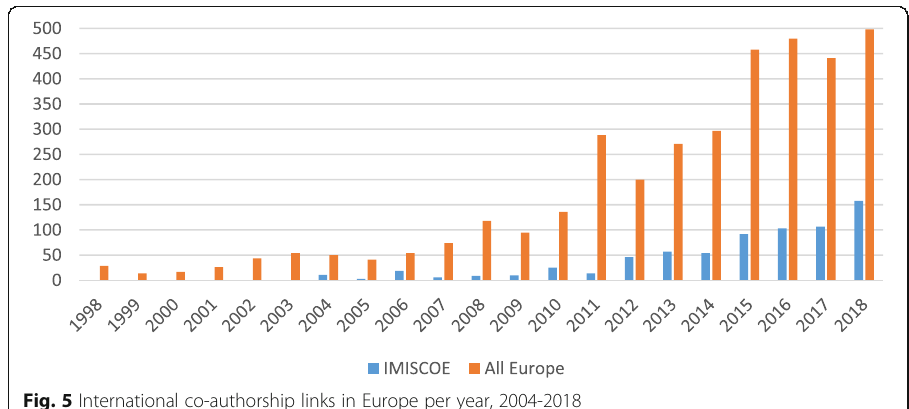
Fig. 5 International co-authorship links in Europe per year,